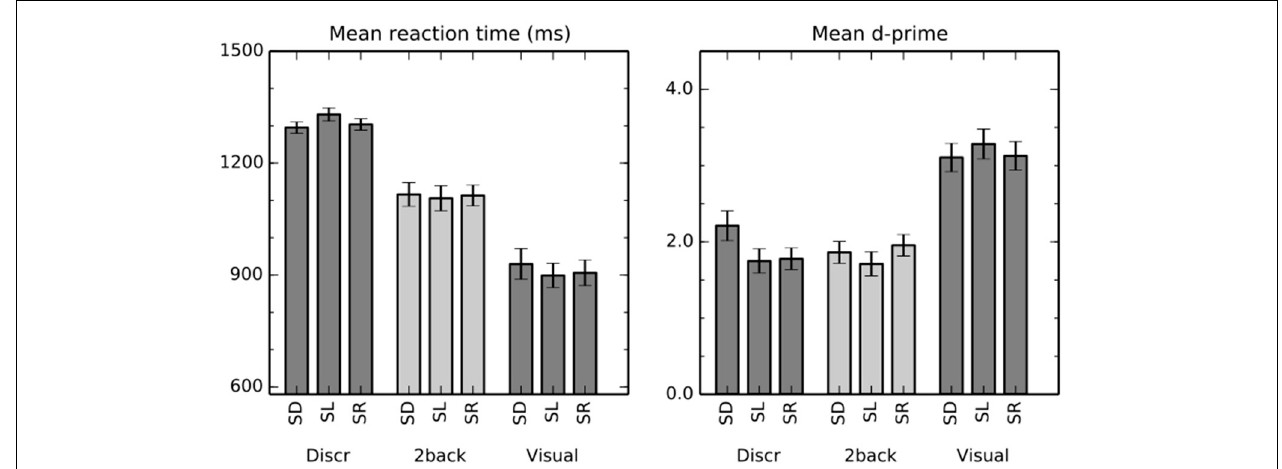
in distance (spatial distance, SD), location in horizontal plane (spatial location, SL), or that were emitted in different rooms (spatial room, SR).